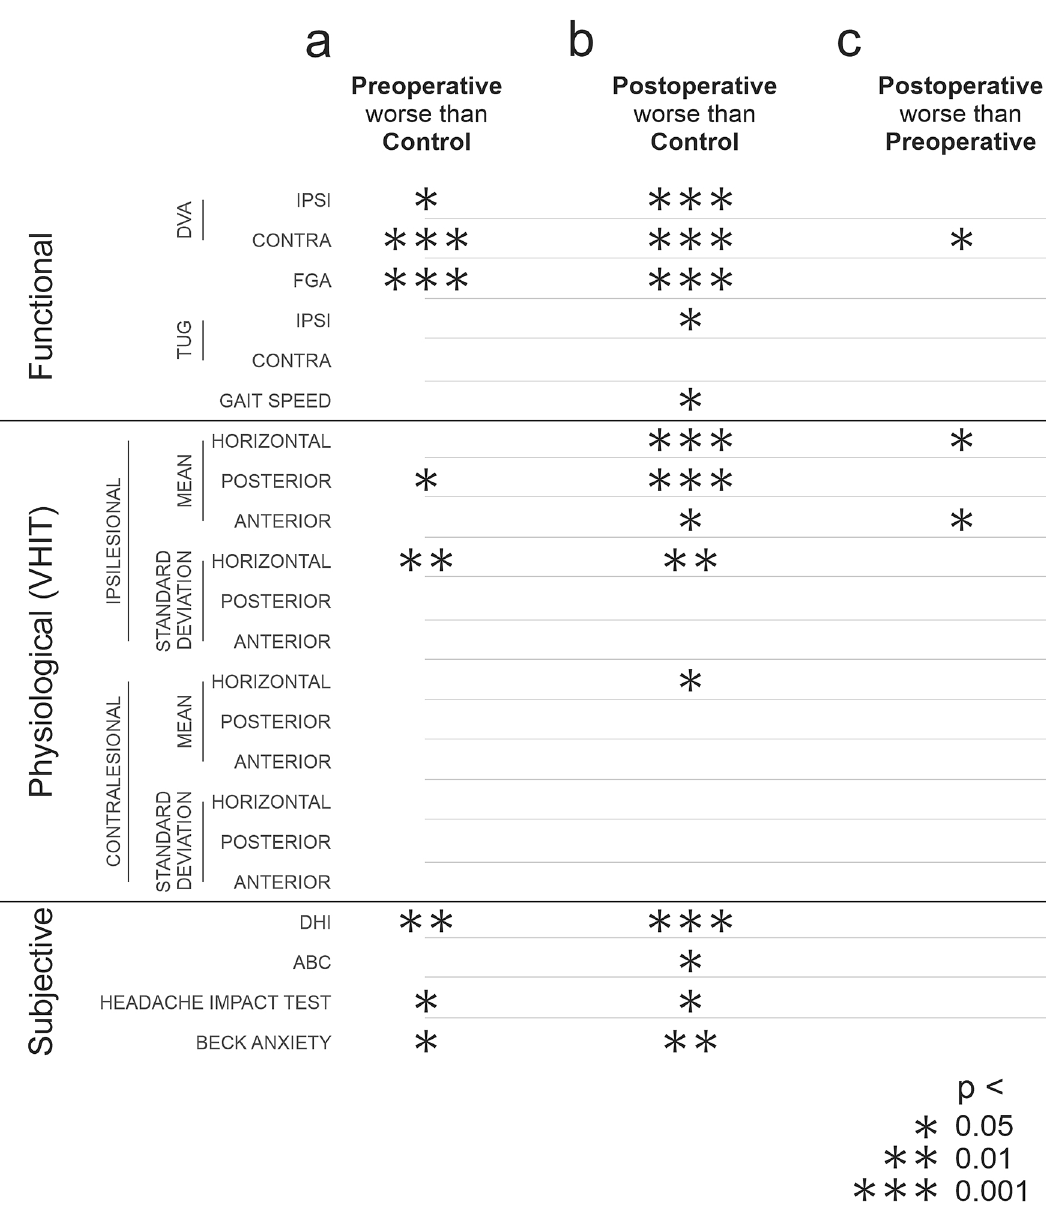
Figure 1. Comparison of clinical measurements across unique domains (clinical, physiologic, subjective) between ( a ) pre-surgery patients and healthy controls, ( b ) post-surgery patients and healthy controls, ( c ) post- surgery patients and pre-surgery patients. Asterisks indicate differences at three significance levels (*0.05, **0.01. ***0.001). DVA, dynamic visual acuity; FGA, functional gait assessment; TUG, timed up and go; vHIT, video head impulse test; DHI, dizziness handicap inventory; ABC, activities-specific balance confidence